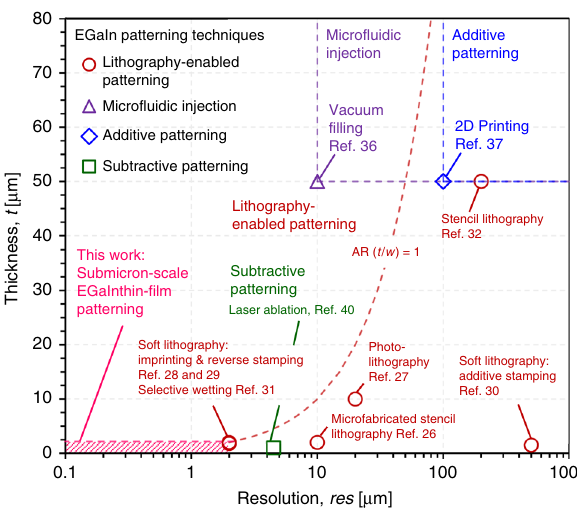
Fig. 6 Liquid metal patterning technologies. Comparison of resolution (minimum line width) and fi lm thickness of published liquid metal (eutectic gallium-indium alloy, EGaIn) patterning technologies as well as proposed nanofabrication technique based on hybrid lithography for submicron